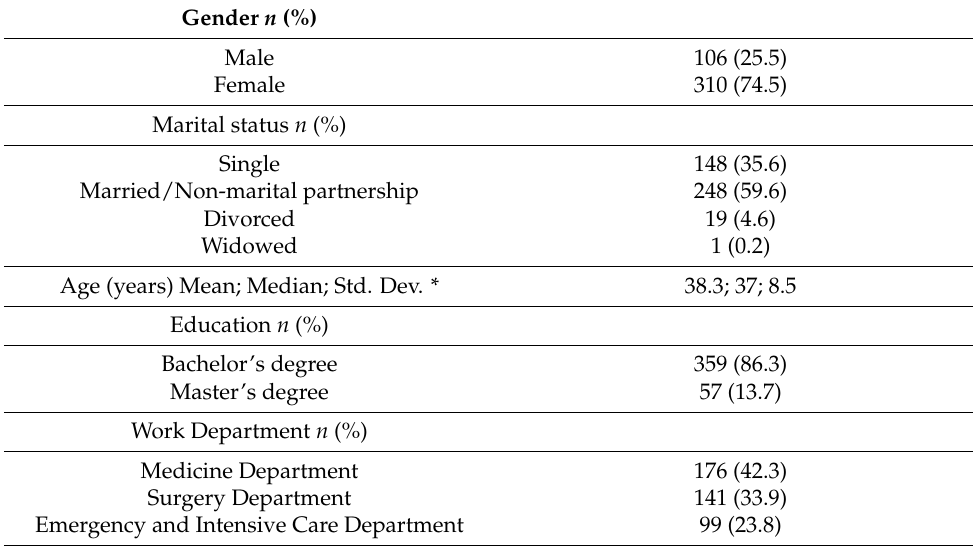
Table 1. Sociodemographic and professional characterisation of the participants ( n =